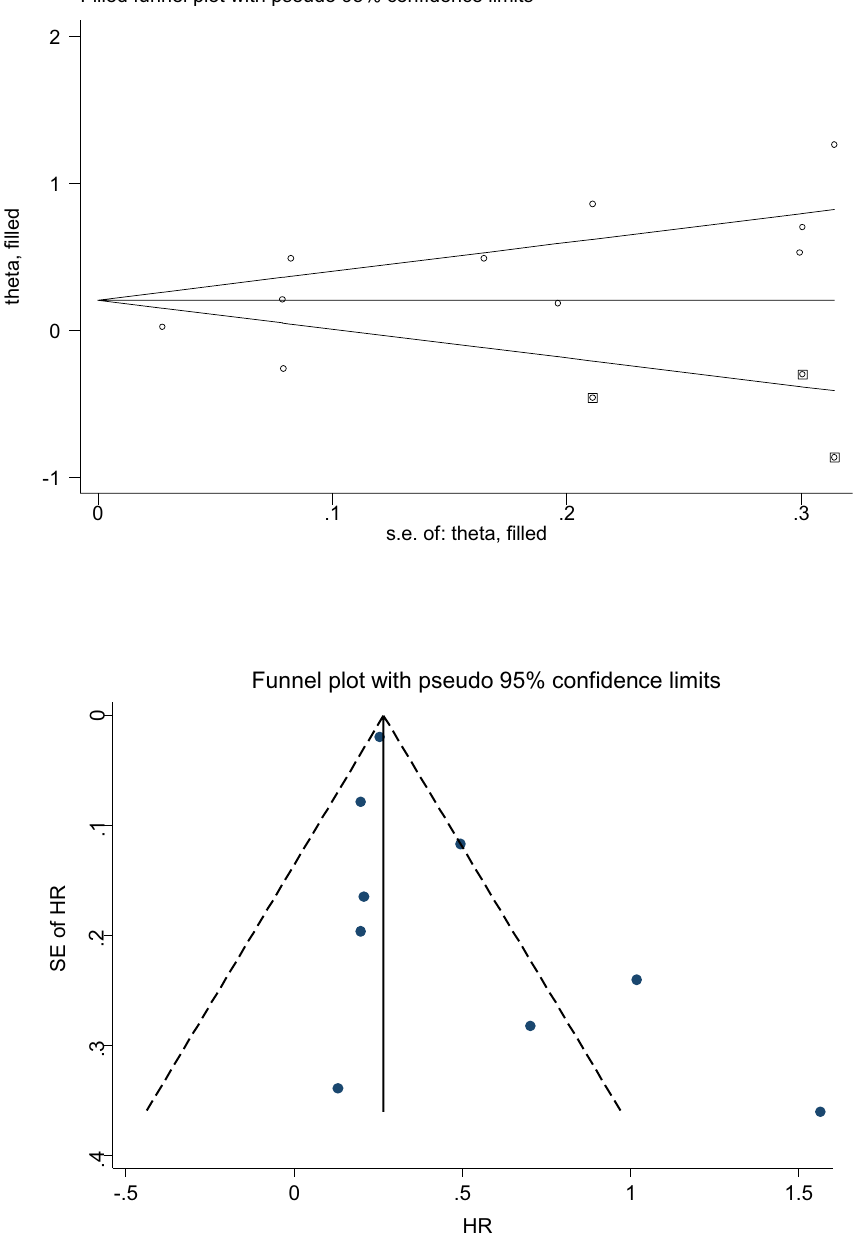
Figure 4. Funnel plots for the association between sensorineural hearing loss (SNHL) and the incidence of stroke in the unadjusted (above) and the adjusted (below) models. HR adjusted hazard ratio, CI confidence